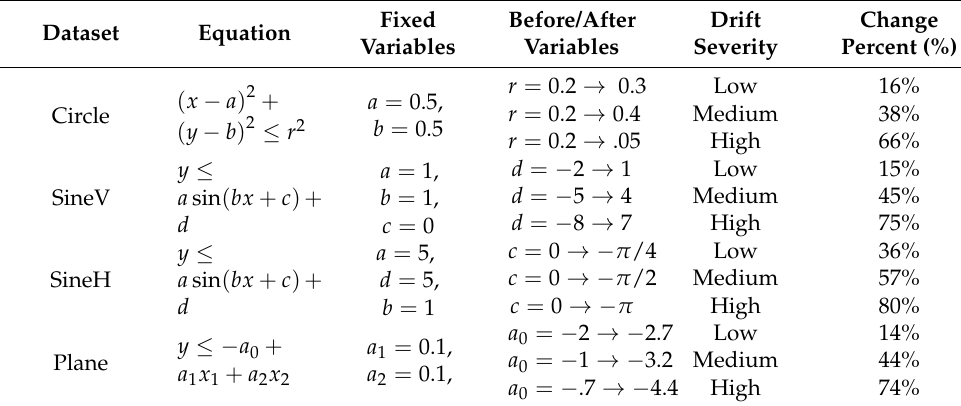
Table 3. Artificial datasets on variable drift magnitude